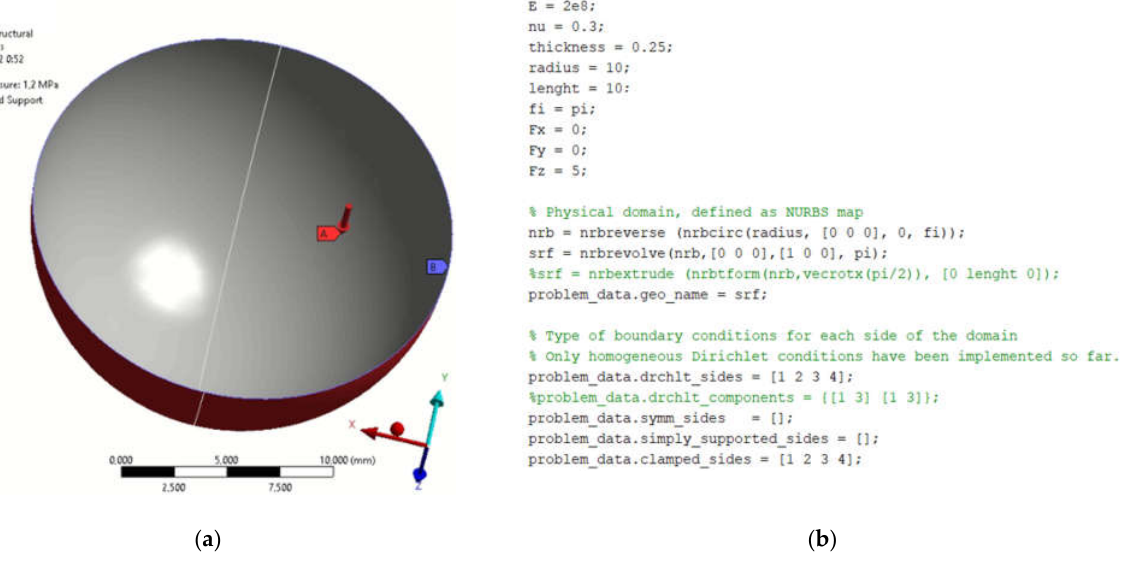
Figure 1. Defining parameters, material constants and boundary conditions in ( a ) FEM program; ( b ) MATLAB.